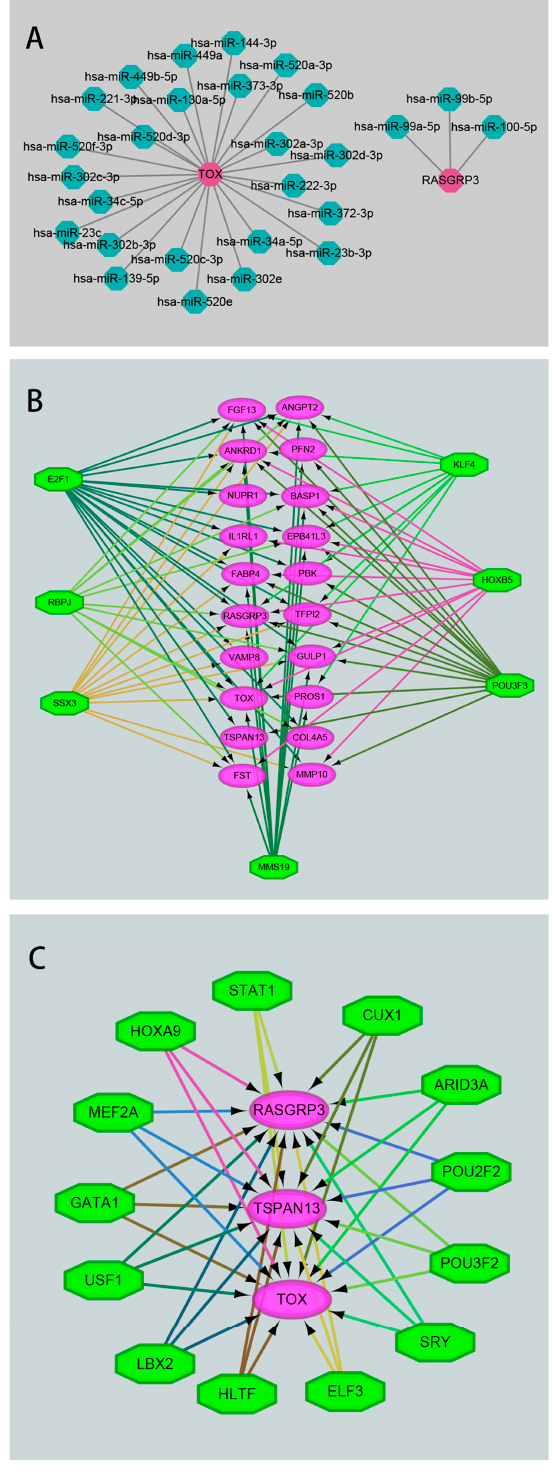
Figure 3. The miRNA–target gene and target gene–TF regulatory network. ( A ) Network diagram of miRNAs regulating TOX or RasGRP3. Bright red represents TOX or RasGRP3, green represents miRNAs. ( B ) Network diagram of TFs regulating 23 significant DEGs. Purple circles indicate 23 significant DEGs, green octagons indicate TFs with targets ≥ 10. ( C ) Network diagram of TFs simultaneously regulating TOX, RasGRP3, and TSPAN13. Purple circles indicate TOX, RasGRP3, or TSPAN13, green octagons indicate